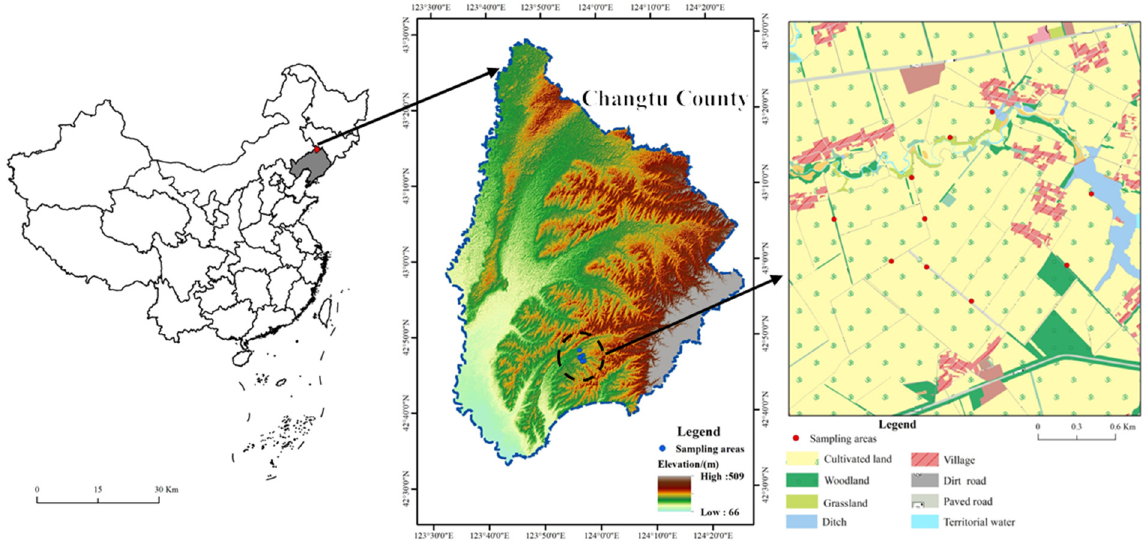
Figure 2. Location of sampling sites in the study area. The upper-left image shows the location of the study area in China; the lower-left image shows the location of the study area in Liaoning Province; and the right image shows the sample areas in the Changtu county. The base map is an elevation map of Changtu with 10 corn fields. Table 1. Five types of field margins, their typical characteristics, and vegetation characteristics. More detail on the field margins monitored can be found in Text S1.